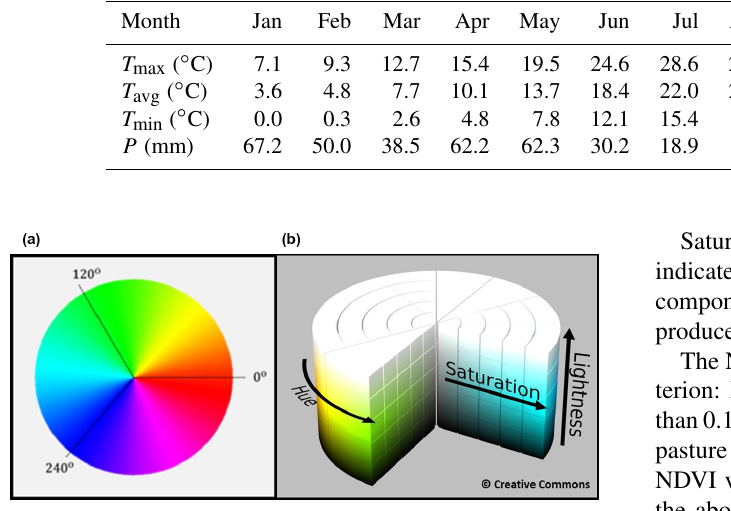
Figure 2. (a) Color wheel of hue. (b) The HSL model (Creative